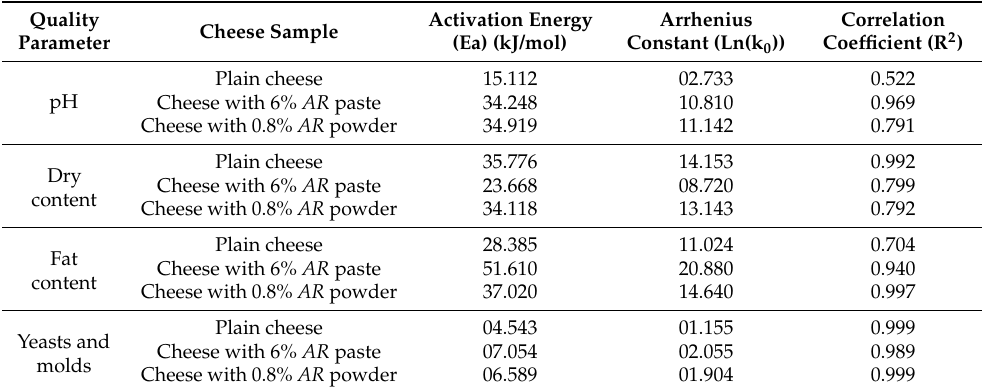
Table 5. Calculation of activation energy, and kinetic constant and values of the different cheese samples.